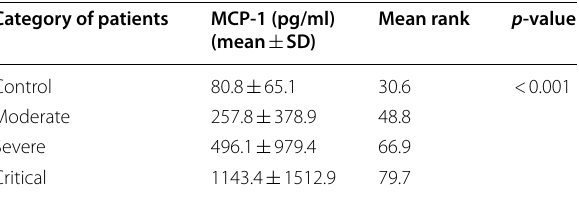
Table 2 Association of serum level of MCP-1 (pg/ml) among different categories of COVID-19 patients and healthy controls ( n 112) = Category of patients